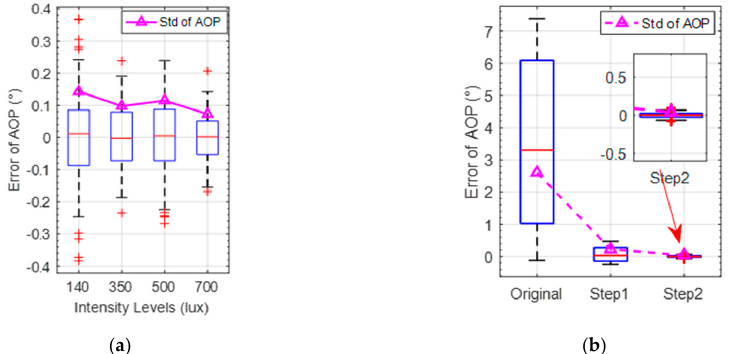
Table 1. Statistics comparison of AOP error under different light-intensity levels.